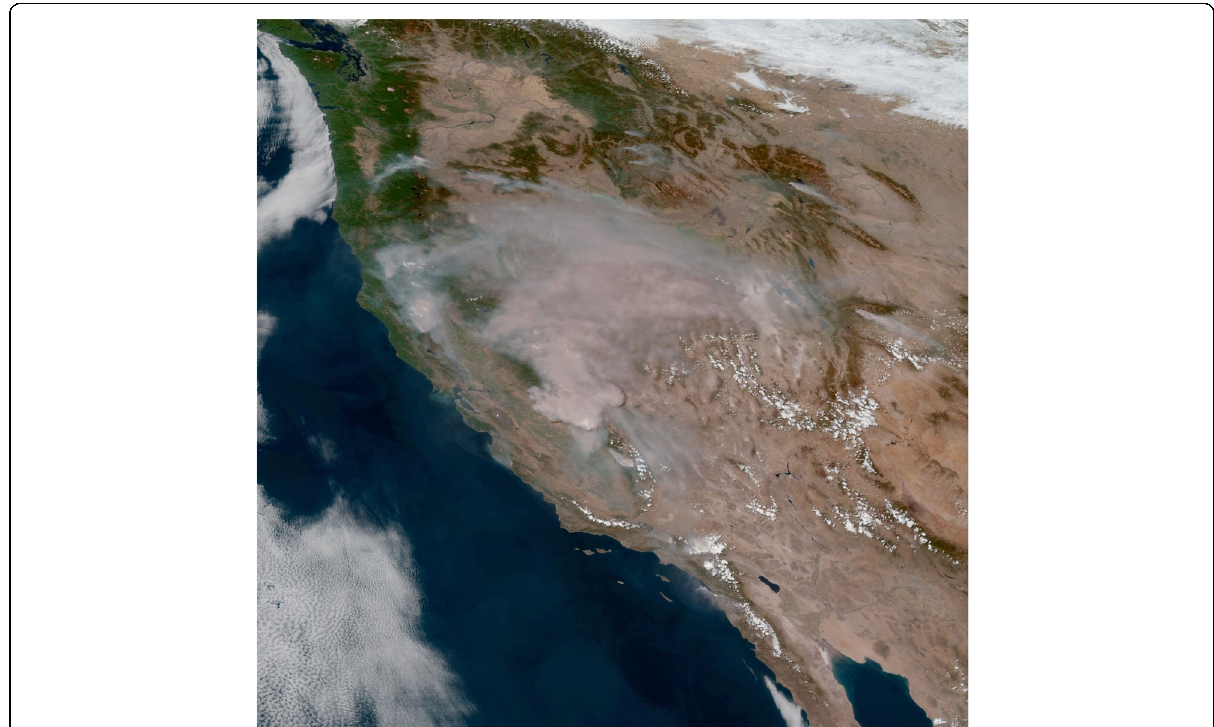
Fig. 27 This zoom image from the GOES image Fig. 26 shows the western United States in more detail. The image covers from the Pacific Ocean to the edge of the Great Plains, east of the Rocky Mountains. There are numerous fires at this time in the